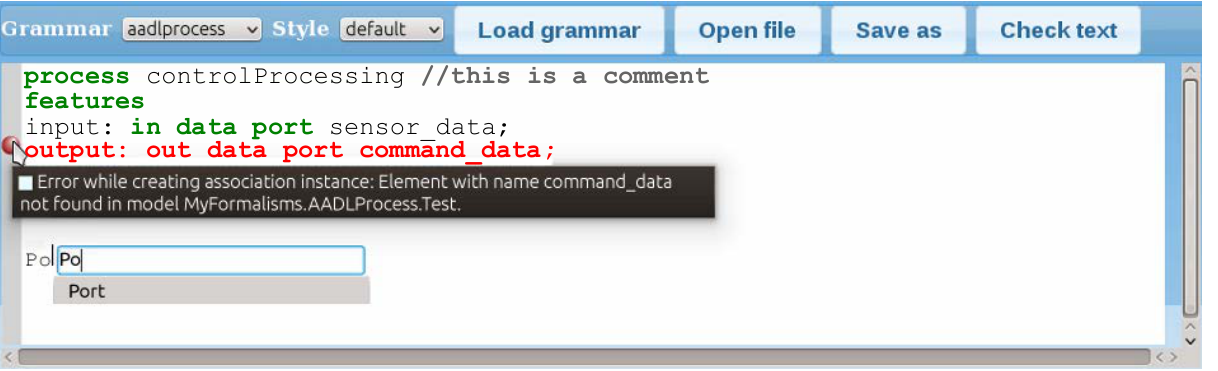
Figure 6. Screenshot of the generated AADL process textual